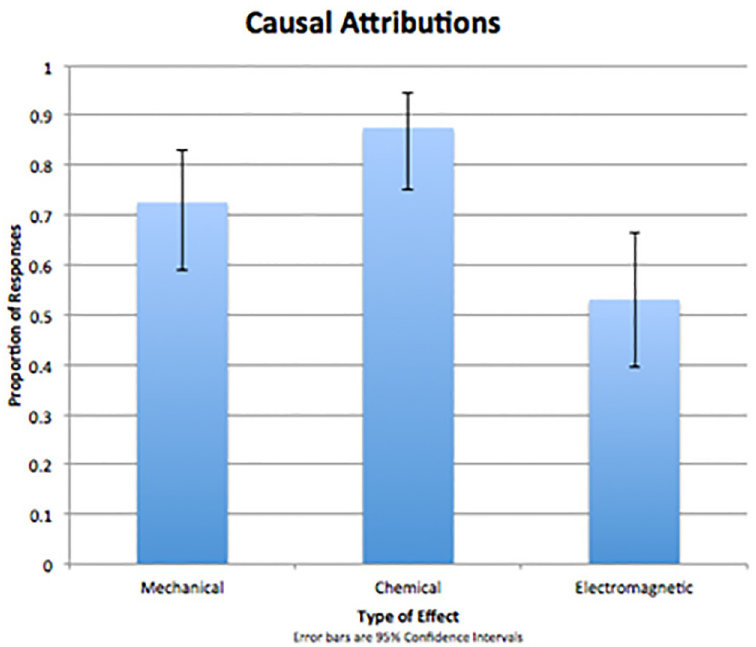
Fig 4. Proportion of responses for which the 1st–ranked cause matched the intended domain of each of the three effects (chance is 33 1 / 3 %; error bars are 95% confidence intervals).